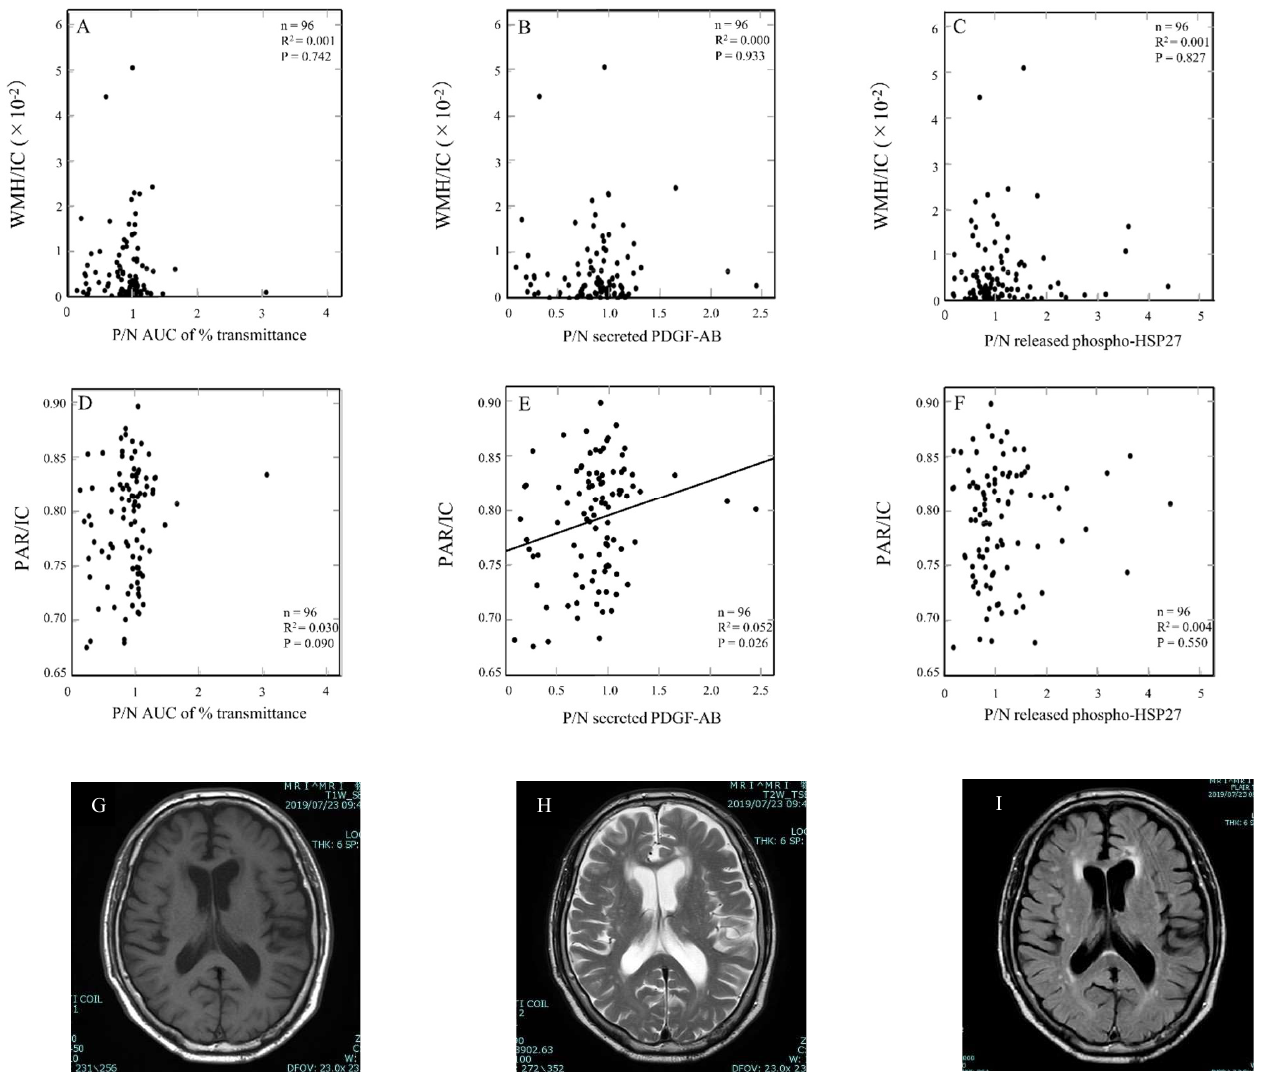
Figure 5. The relationship between individual levels of magnetic resonance (MR) imaging findings and Aβ-effects on the aggregation, secreted PDGF-AB and released phosphorylated HSP27 in TRAP-stimulated human platelets of DM patients. White matter hyperintensity (WMH) and brain atrophy in MR imaging were analyzed individually by an automatic segmentation application (SNIPER). Global brain atrophy was calculated as the parenchyma (PAR) volume. WMH and PAR were divided by the intracranial (IC) volume to adjust for the size of each patient’s brain. ( A – C ) WMH/IC were plotted against P/N AUC of % transmittance ( A ), P/N secreted PDGF-AB ( B ), P/N released phosphorylated HSP27 ( C ). ( D – F ) PAR/IC were plotted against P/N AUC of % transmittance ( D ), P/N secreted PDGF-AB ( E ), P/N released phosphorylated HSP27 ( F ). These data were plotted and analyzed by linear regression analysis. Representative MR images with 1.5T MR scanners are shown; T1-weighted ( G ), T2-weighted ( H ) and FLAIR ( I ) MR imaging.